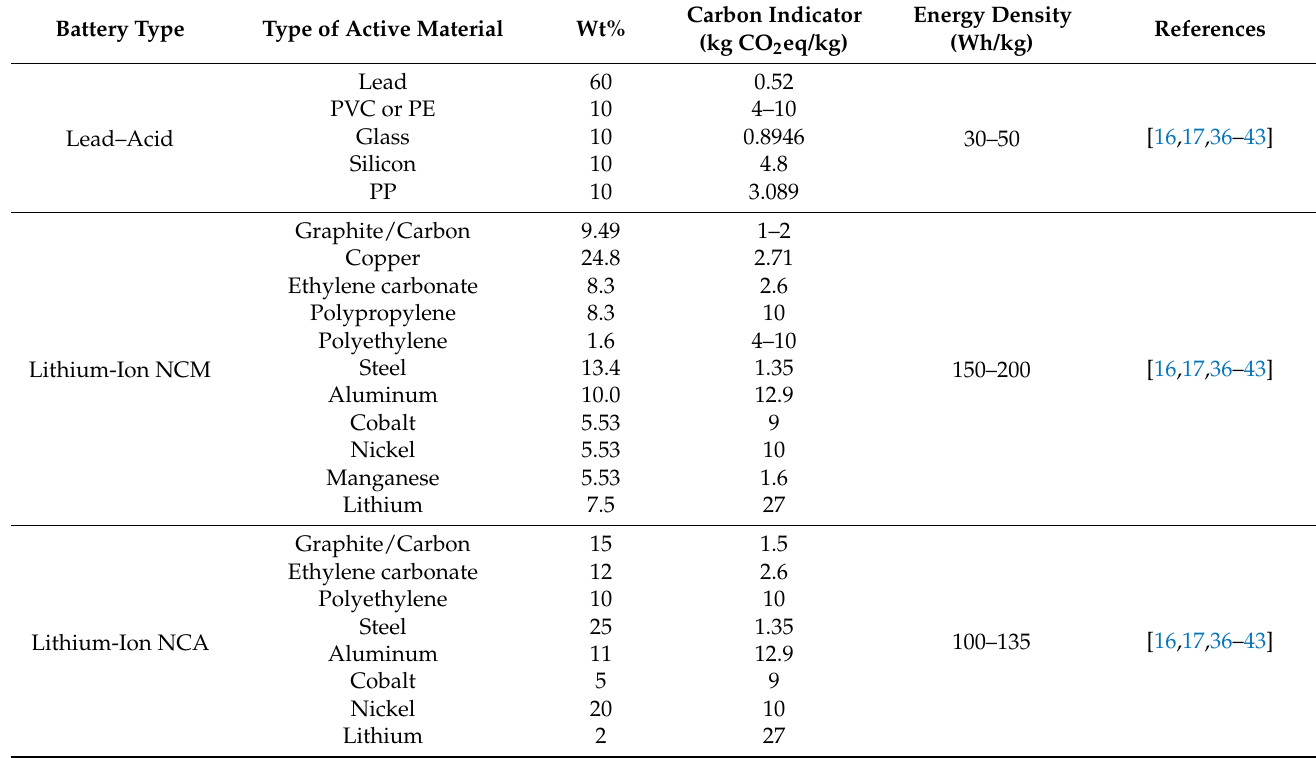
Table 2. Review analysis of batteries’ characteristics regarding carbon emissions and energy